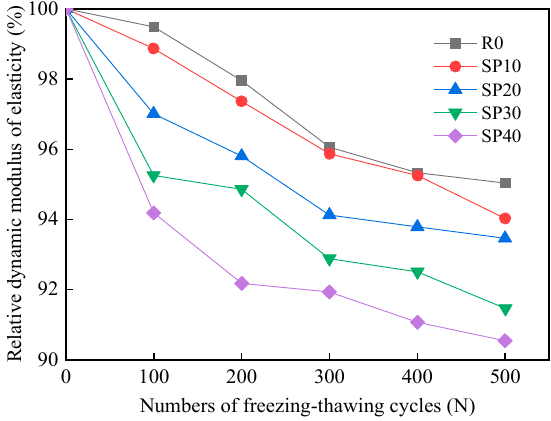
Figure 14. E ff ect of slag powder content on RDME of Figure 14. Effect of slag powder content on RDME of CGAC.